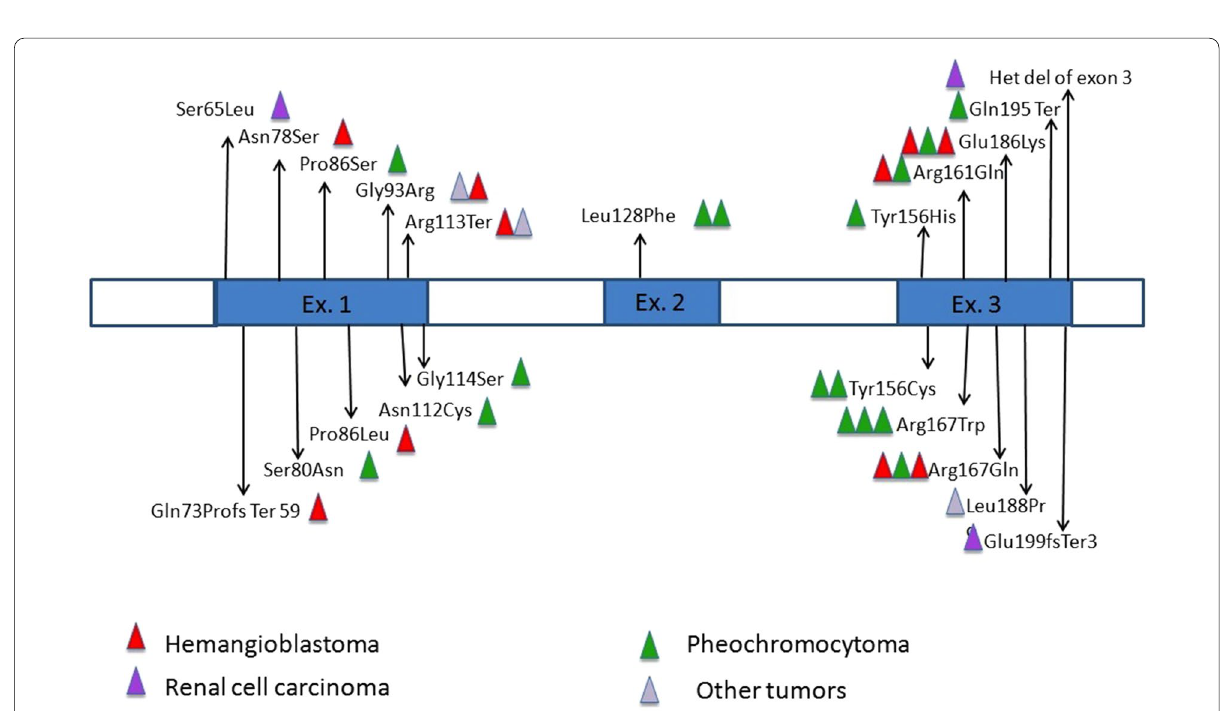
Fig. 2 Distribution of Mutations across VHL gene along with the tumors at presentation